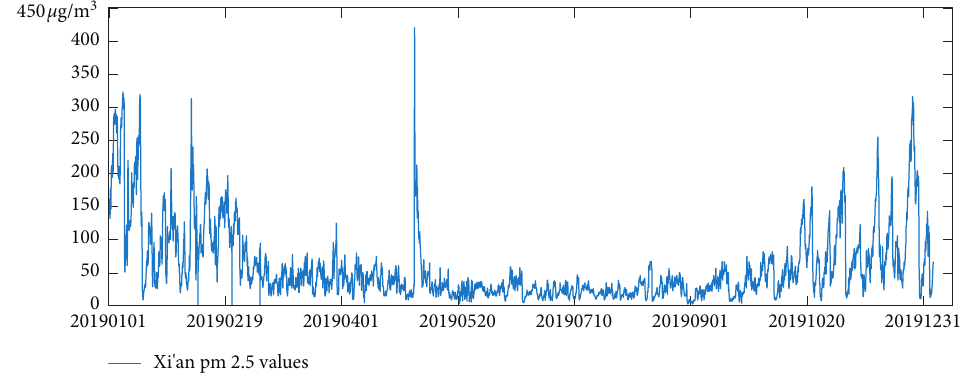
Figure 4: The distribution of the original data. Table 1: Basic descriptive statistics of PM 2.5 concentration